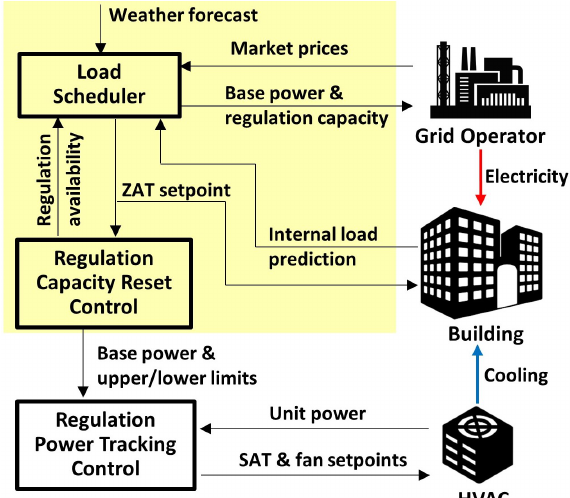
Figure 2. Control diagram of proposed